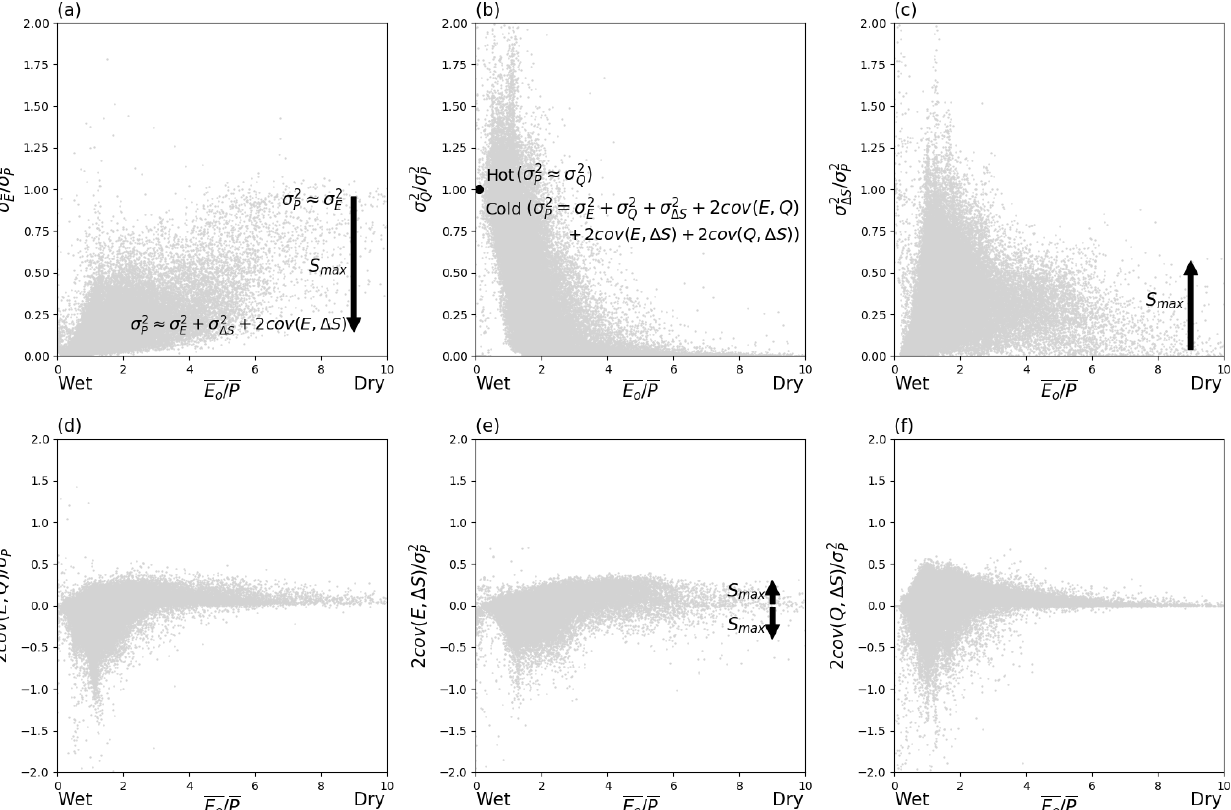
Figure 12. Synthesis of factors controlling variance partitioning. The arrows denote trends with increasing S max . The grey background dots are from Fig.